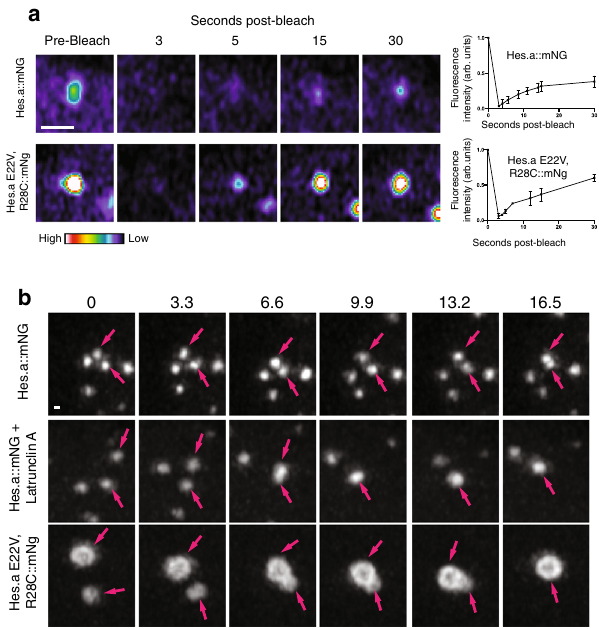
Fig. 6 Hes.a FRAP/fusions. a Time-lapse maximum intensity projection confocal images of region of a single Hes.a puncta. Images show the puncta prior to photobleaching and the recovery at several timepoints. Fluorescent intensity is indicated by the look up table. Scale bar = 1 μ m. b Quanti fi cation of FRAP recovery of Hes.a droplets. Dots indicate the mean and the error bars indicate the standard deviation ( N = 3). c Time-lapse maximum intensity projection confocal images of Hes.a puncta. 2 puncta are indicated with arrows and if they fuse are indicated by a single arrow. Scale bar = 0.5 μ m. All transgenes were expressed using pSP Sox1/2/3 >plasmids. FRAP and fusion images are representative of >3 biological replicates. Source data are provided as a Source Data fi le.